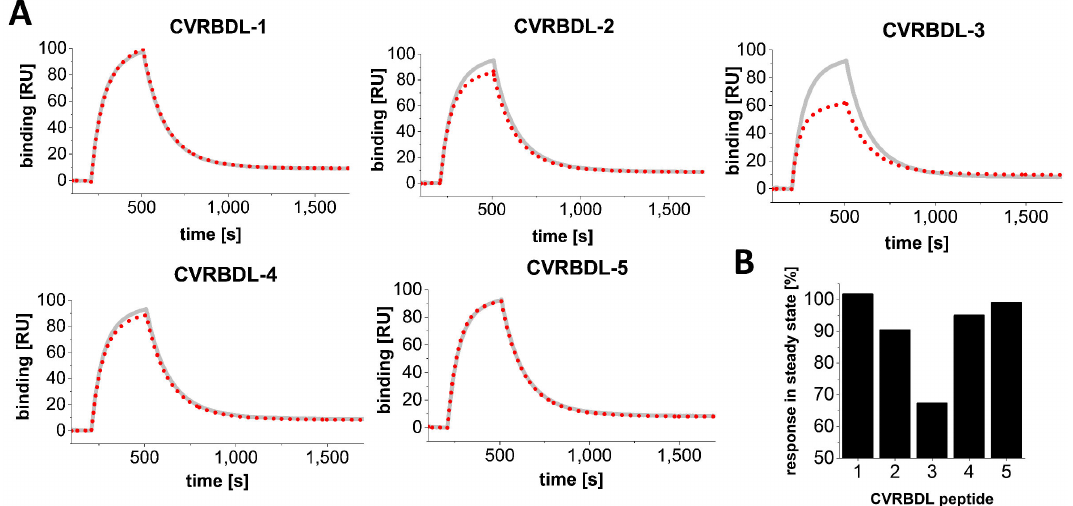
Figure 5. SPR inhibition assay of SARS-CoV-2 S1S2 spike interaction to hACE2 with and without compounds CVRBDL-1 to -5. ( A ) hACE2-fc was immobilized on a protein A/G derivatized sensor surface in a T200 SPR device (Cytiva, USA). 50 nM SARS-CoV-2 S1S2 was injected with (red dotted line) or without (solid grey line) 5 µ M of compounds CVRBDL-1 to -5. Prior to each injection of S1S2 with compound, a separate injection without compound was performed. All injections with compound were referenced with compound ‐ only injections on the hACE2 immobilized surface. Injections were performed with a flow rate of 30 μ L/min in 10 mM HEPES (pH 7.4), 150 mM NaCl, 3 mM EDTA, 0.005% ( v / v ) Tween ‐ 20. ( B ) Relative steady state responses of the injections with compound